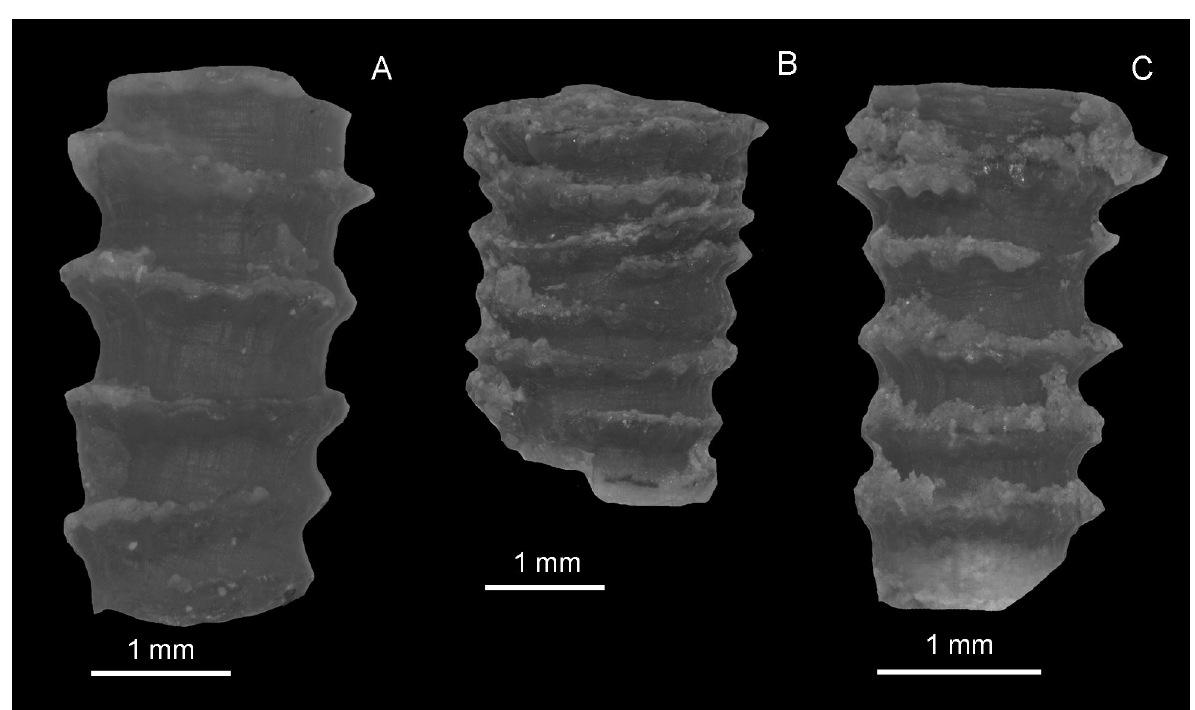
Fig. 3. A (cid:150) C . Conchicolites crispisulcans sp. nov. from the Mulde Brick-clay Member of the Halla Formation, Homerian of